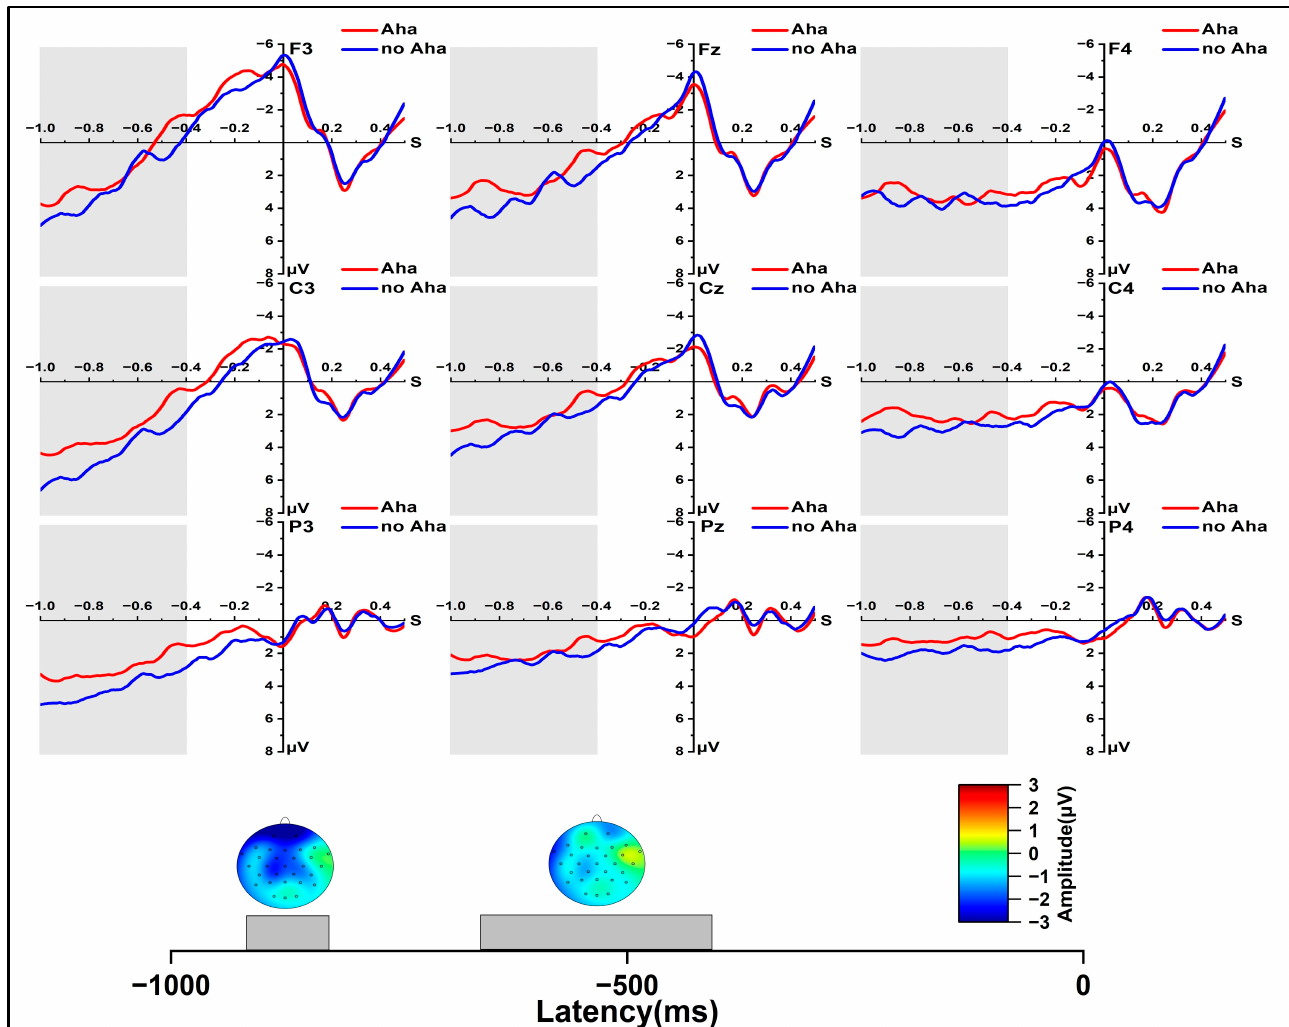
Figure 6. Grand‑average ERPs from all selected channels for Aha and no Aha conditions and spherical‑spline interpolated scalp distributions of the solution type (Aha minus no Aha) in − 900 to − 800 ms and − 800 to − 400 ms time